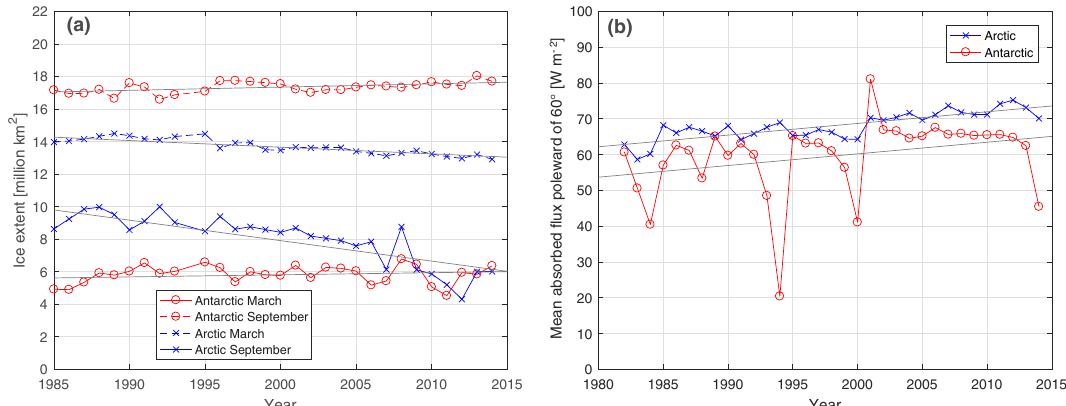
Figure 1. (a) Long-term trends of sea ice extent: temporal evolution of sea ice extent in Antarctica (red) and the Arctic (blue) for minimal (solid line) and maximal (dashed line) seasonal extent as derived from APP-x data. Grey lines indicate fitted linear trends. (b) Annual mean flux into ice–ocean system: shortwave radiative flux absorbed by the ice–ocean system poleward of 60 ◦ latitude in the Arctic (crosses) and Antarctic